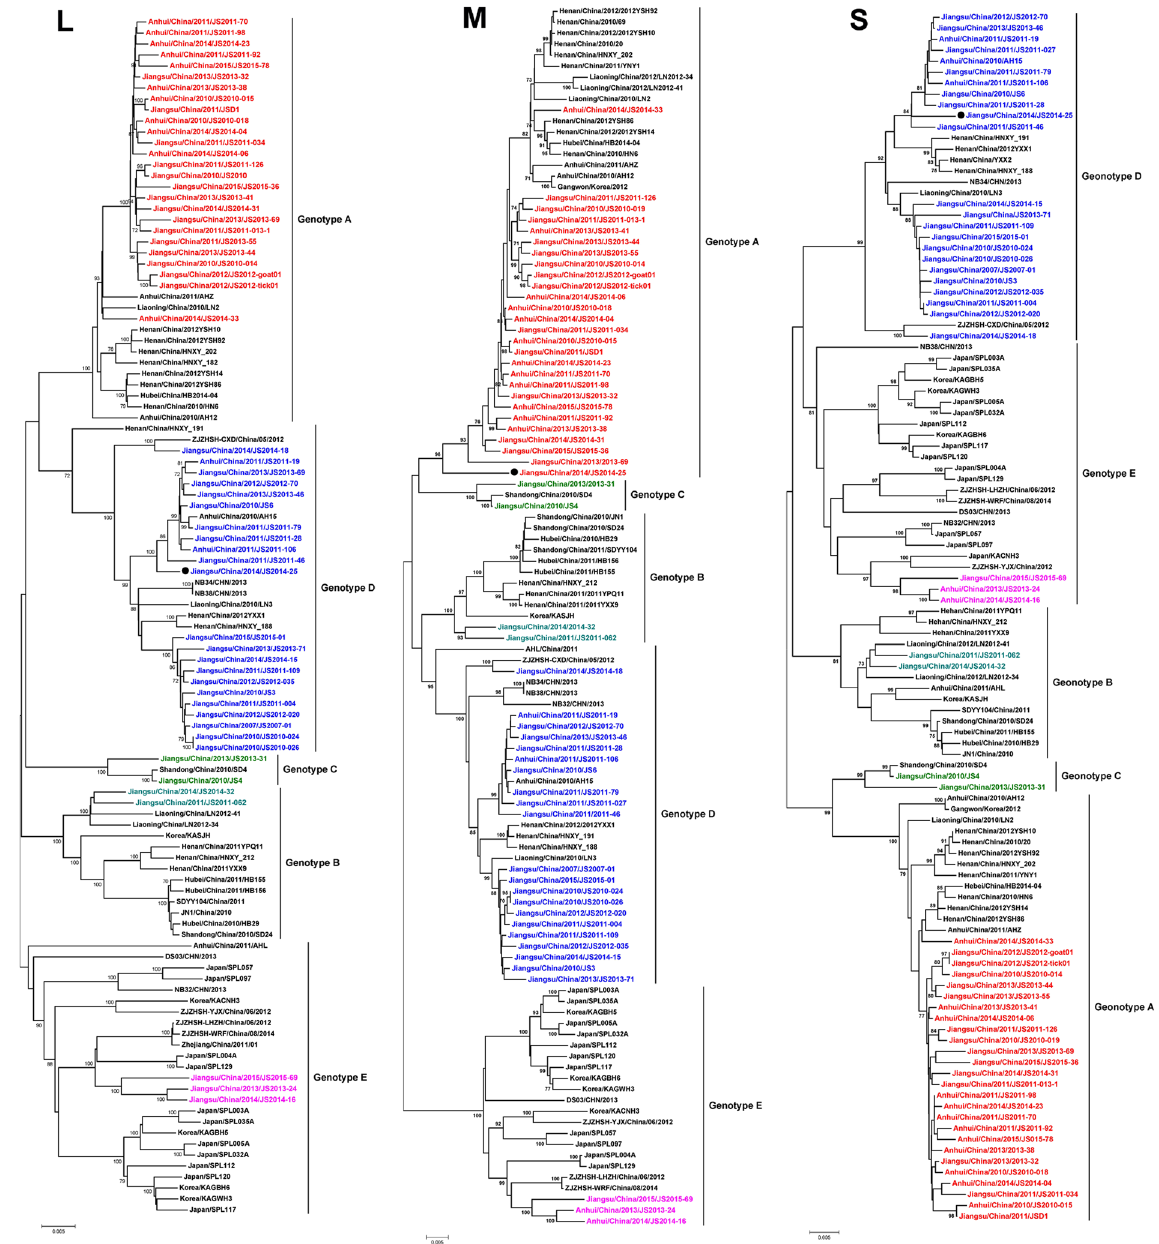
Figure 4. Phylogenetic analysis of SFTSV strains isolated from Jiangsu and Anhui provinces during 2010 and 2015, compared with SFTSV strains from other areas. The phylogenetic trees were constructed using the Maximum Likelihood Method with the MEGA5.1 software based on L, M and S segments of SFTSV strains from different SFTS endemic areas. The reliability values indicated at the branch nodes were determined using 1,000 bootstrap replications. Bootstrap value ≥ 70 were labeled at nodes. The sequences were named according to province/country/year of collection or isolation/strain. Colored taxon names of the phylogenetic trees presented SFTSV strains isolated in this study. The red taxon names were the SFTSV strains of Jiangsu and Anhui provinces distributed in genotype A, while green, cyan, blue and pink represented SFTSV strains of this study clustered in genotype B, C, D and E, respectively. The SFTSV strains isolated from north part of the epidemic area of Jiangsu and Anhui provinces distributed into genotype A and most of the SFTSV strains from south part of the epidemic area belong to genotype D. There were two SFTSV strains from the central of the epidemic areas clustered into genotype C. There were three SFTSV strains, two from Huoshan and Qianshan of Anhui and one from Yixing of Jiangsu, clustered into genotype E. The SFTSV strain with reassortment was labeled with black solid